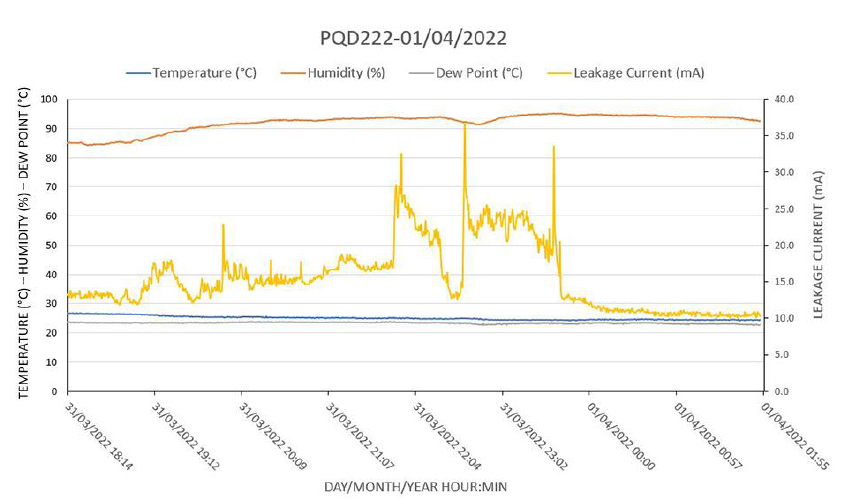
Figure 17. Some of the worse conditions that a polluted insulator can experience: high humidity, cool weather, heavy rain, and the temperature dropping to the dew point. The system detected an LC peak of 35 mA.